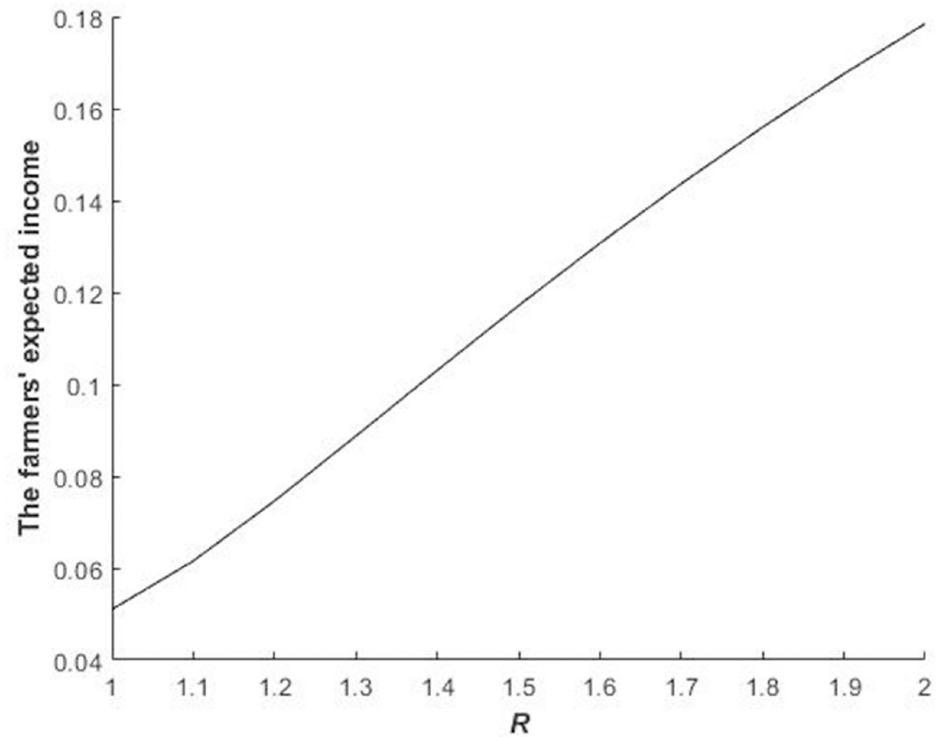
Fig 5. Impact of R on the farmers’ expected